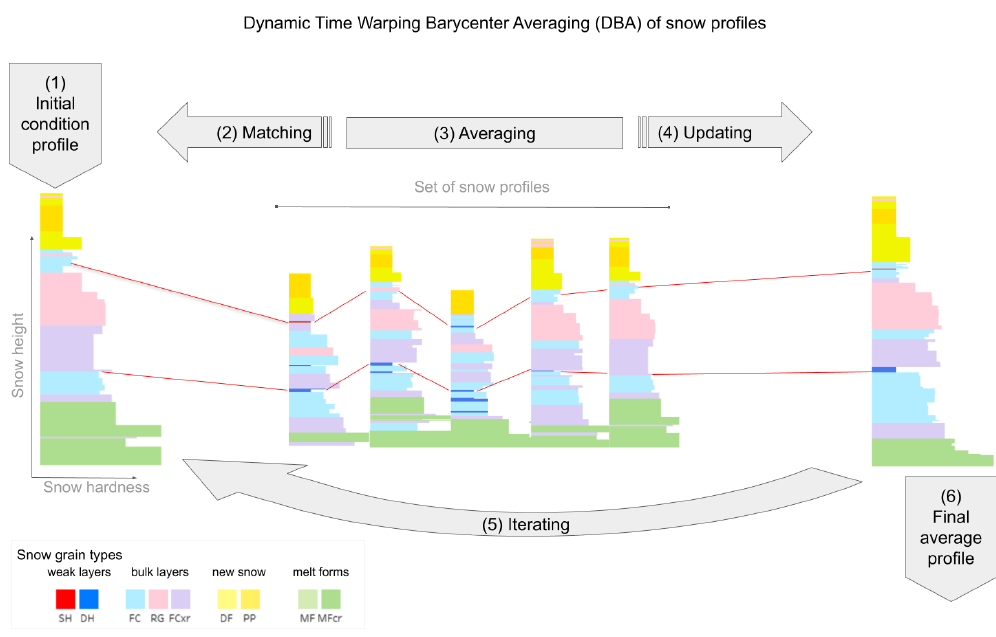
Figure 1. Conceptual flowchart demonstrating how dynamic time warping barycenter averaging (DBA) can be applied to snow stratigraphy profiles. (1) An initial condition profile is picked from the data set of profiles to act as a reference profile. (2) All layers from all profiles in the set are matched against the reference profile (red line segments highlight two sets of corresponding layers), and (3) all sets of corresponding layers are averaged to (4) update the reference profile. (5) This process is repeated several times until the reference profile does not change substantially anymore and therefore (6) represents the final average profile of the